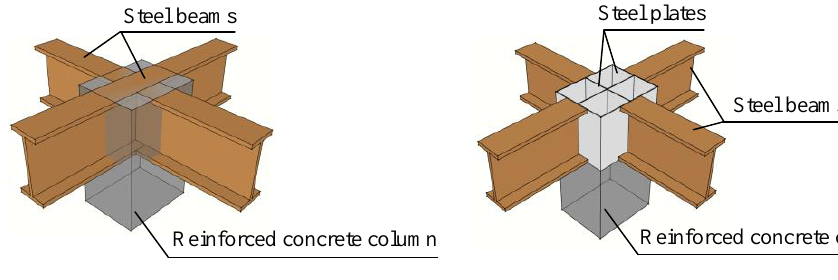
Figure 1. Two types of beam–column joint.